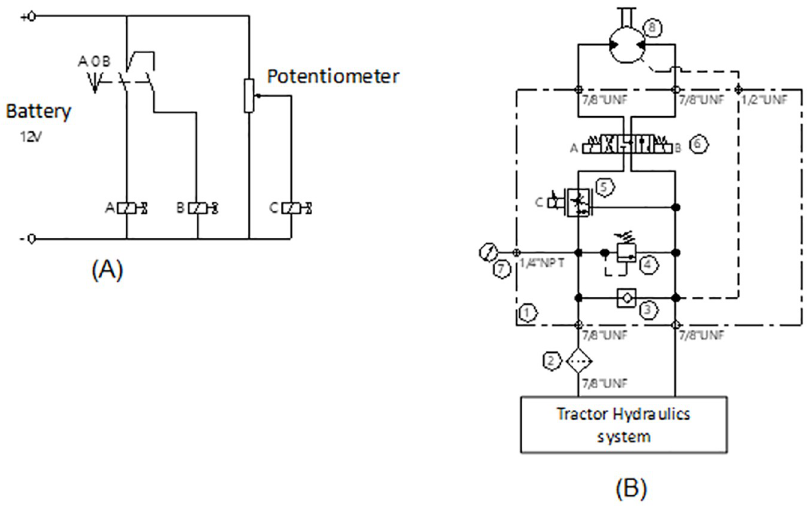
Fig 1. The electrohydraulic system driving the vibrating conveyor belt of the peanut digger-inverter: a) electric circuit; B) electrohydraulic circuit. (1) Manifold � ; (2) Hydraulic filter; (3) Check valve; (4) Pressure regulating valve (5) Proportional flow control valve; (6) Directional valve; (7) Pressure gauge; (8) Hydraulic motor. � Manifold is a set of valves mounted in a single block.